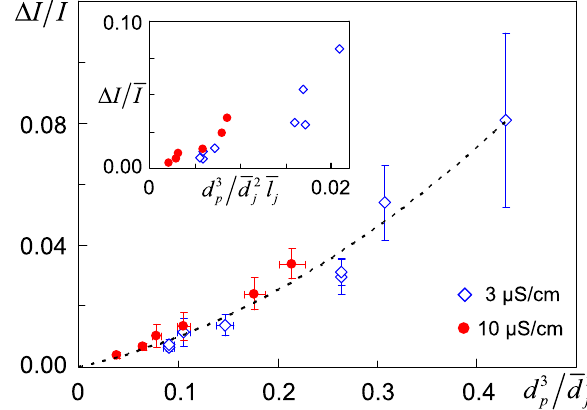
FIG. 6. Oscilloscopic and microscopic measurements confirm- ing the resistive sensing of particles. A short nozzle length of 3 mm was chosen to provide a well-defined (cid:3) I= damping (cf. Fig. 5). When nonconducting particles with a diameter of 10 (cid:1) m (bottom image) and 7 (cid:1) m (top image) are passed through a cone-jet bridge with a diameter of 15 (cid:1) m , the oscillations of the bridge current indicate the passage and relative size of these particles, which are confirmed with syn- chronized imaging in Video 4 [35].